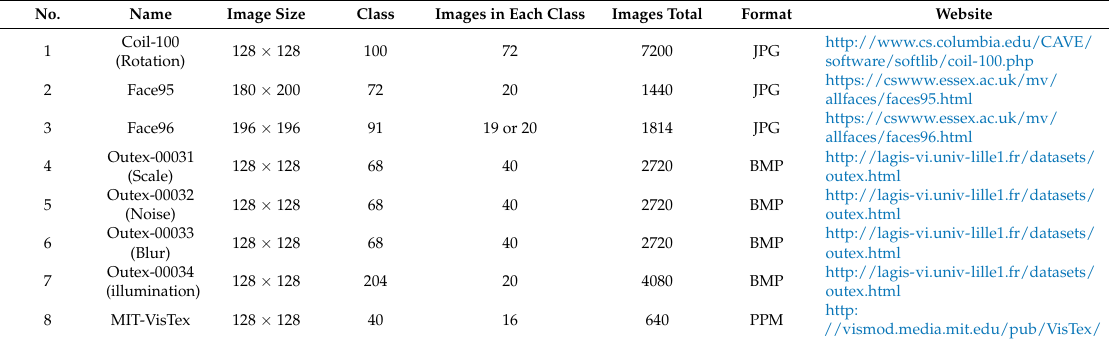
Table 1. Summary of image